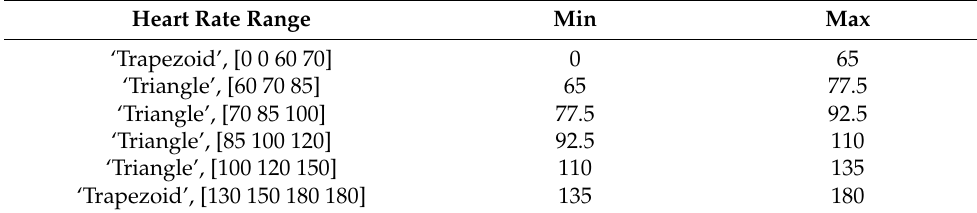
Table 2. The range of each membership function for input 1.